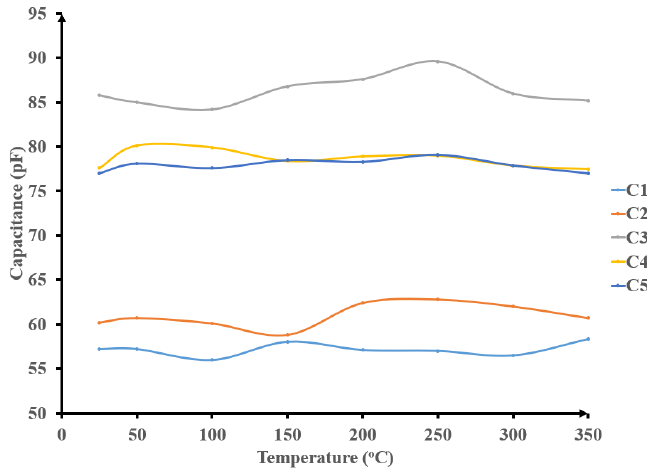
Figure 5. HT characterization of different integrated resistors: ( a ) R1; ( b ) R3; ( c ) R7; ( d ) R8.